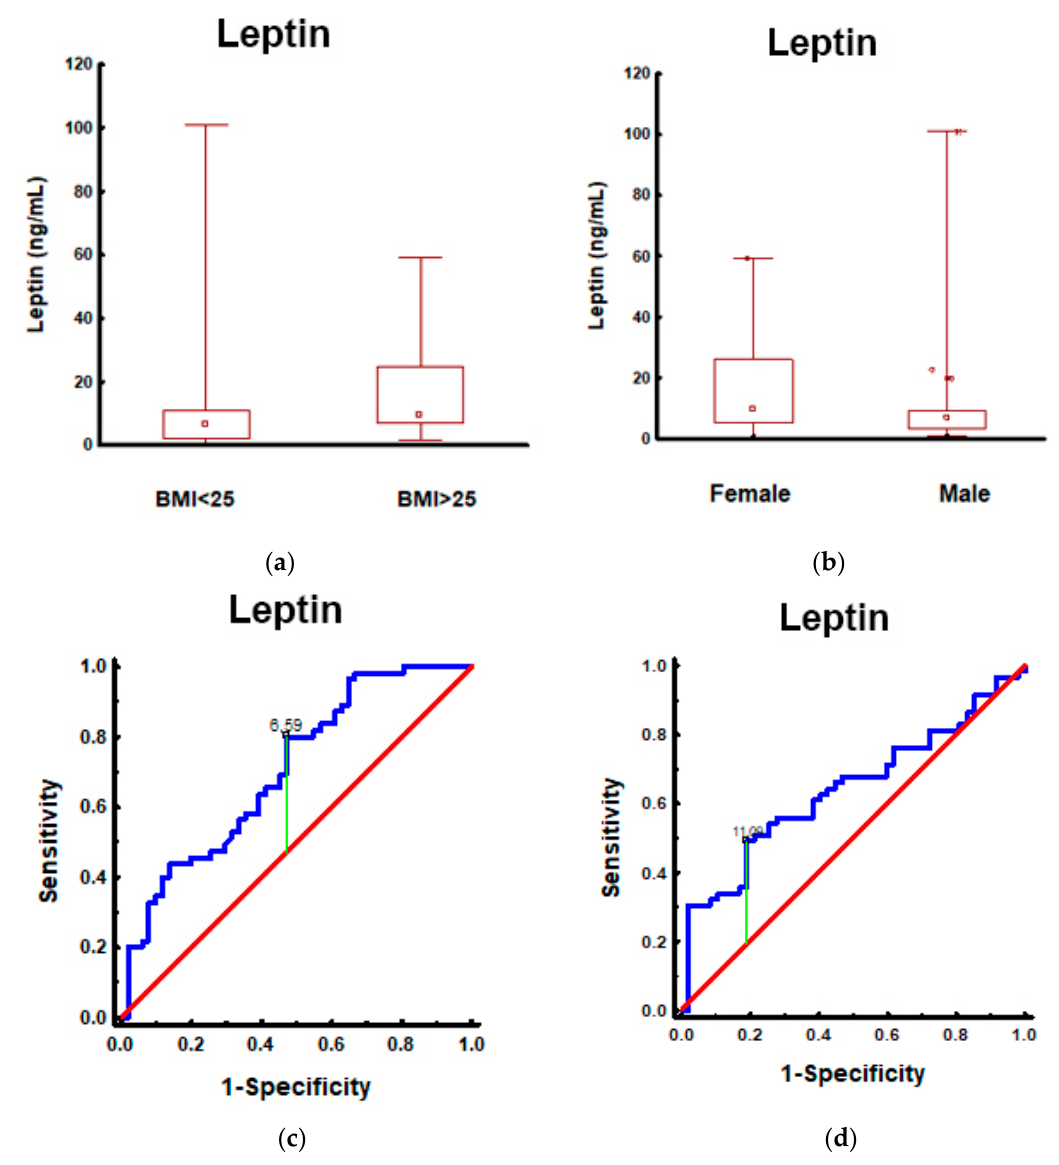
Figure 2. Leptin in patients with PanNEN according to BMI and sex: ( a ) Mann–Whitney test. Leptin in PanNEN patients with normal BMI and elevated BMI: measurements of the leptin identi fi ed elevated levels in patients with PanNEN with BMI ≥ 25 kg/m 2 vs. BMI < 25 kg/m 2 ( p < 0.001); ( b ) Mann–Whitney test. Leptin in patients with PanNEN according to the sex: measurements of the leptin identi fi ed elevated levels in patients with PanNEN: female vs. male ( p = 0.013); ( c ) the AUROC for leptin levels in patients with PanNEN with BMI ≥ 25 kg/m 2 and BMI < 25 kg/m 2 . The AUROC (blue line) for di ff erentiating patients with PanNEN with BMI ≥ 25 kg/m 2 from BMI < 25 kg/m 2 was 0.71 (95%CI: 0.61–0.80. p < 0.001); ( d ) the AUROC for leptin levels in patients with PanNEN: female and male. The AUROC (blue line) for di ff erentiating females and males was 0.64 (95%CI: 0.54–0.75. p = 0.008).